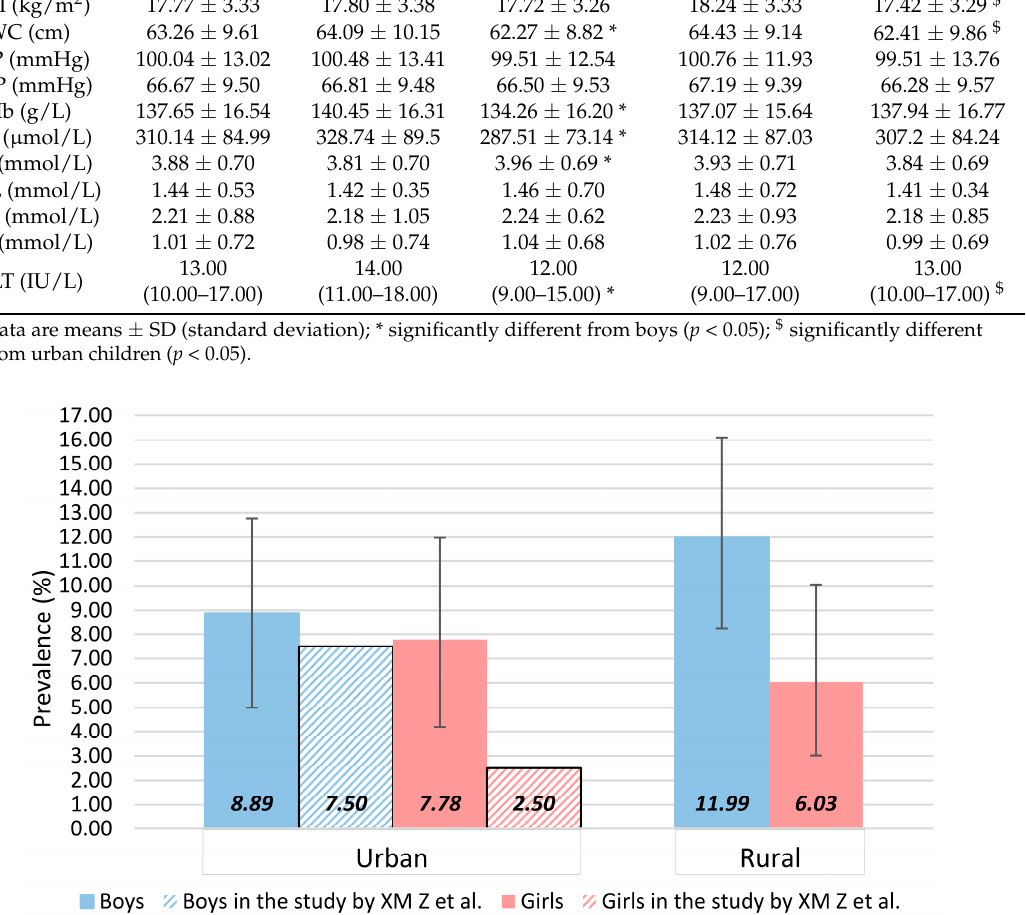
Figure 1. Gender- and residence-specific prevalence of childhood suspected nonalcoholic fatty liver disease (NAFLD) and the comparison with the results from the study by XM Zhang et al. (data from [17]).